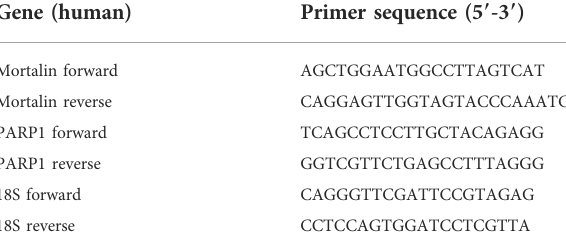
TABLE1PrimersequencesusedforRealTimequantitativePolymerase Chain Reaction